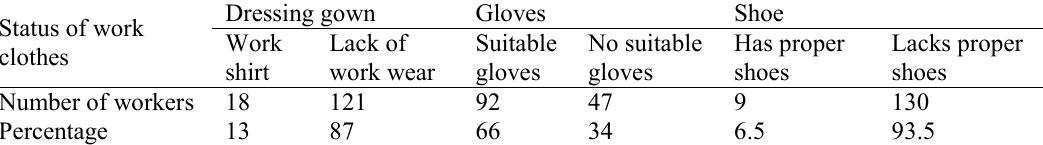
Table 4. Status of workers' clothes Status of